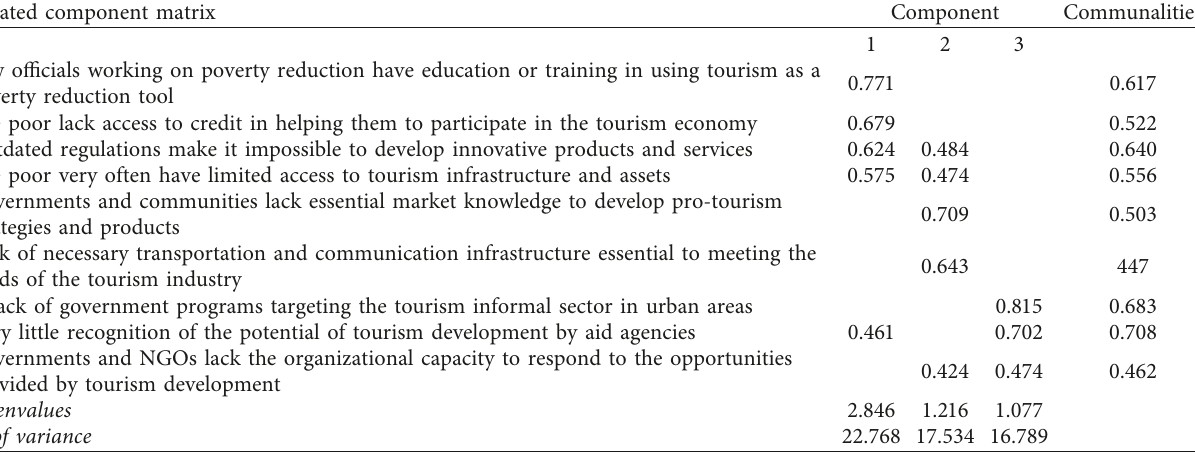
Table 9: Rotated component matrix.